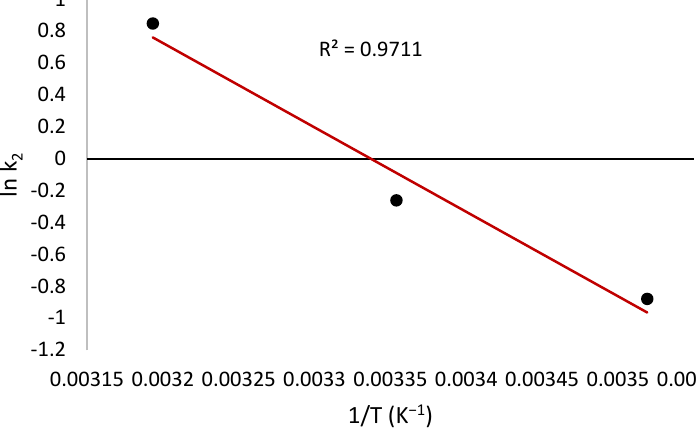
Figure 9. Plot of ln k 2 versus 1/ T of the adsorption process.